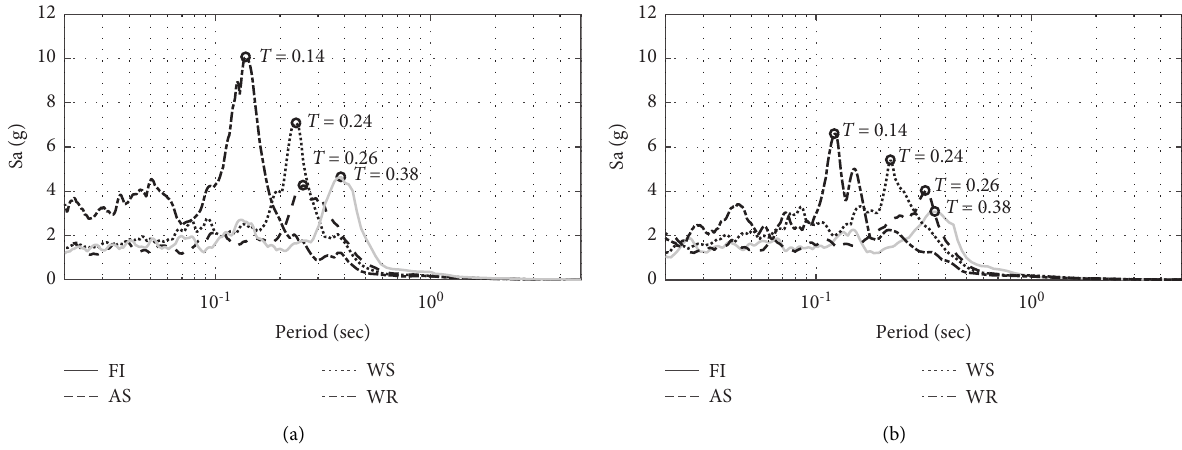
Figure 6: ARS and the periods where peaks appear for each soil condition in the free-field analysis by the Gyeongju earthquake. (a) EW direction. (b) NS